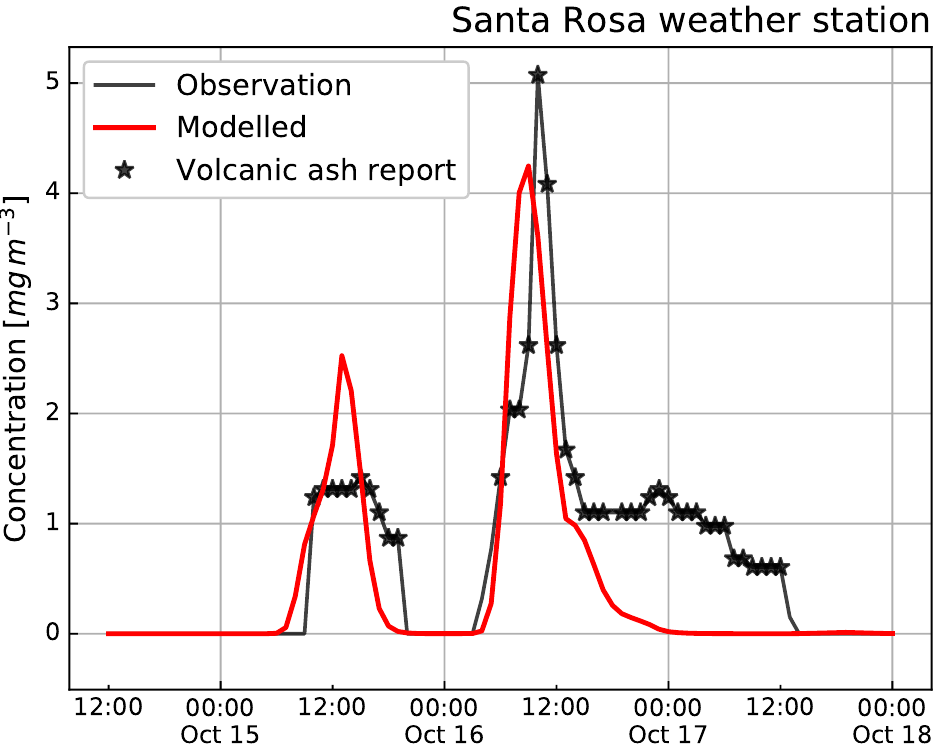
Figure 17. Two consecutive resuspension events detected at Santa Rosa weather station (36°36 (cid:48) S, 64°16 (cid:48) W) during the October 2011 outbreak. Surface concentration according to model (solid red line) and observational data (solid black line) derived from hourly reports of visibility are in good agreement. Ash-in-suspension reports are indicated by